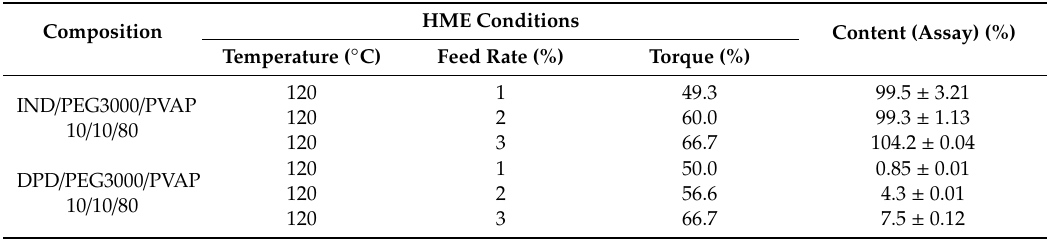
Table 3. Hot-melt extrusion process parameters for the drug-containing amorphous solid dispersions (ASDs) including drug